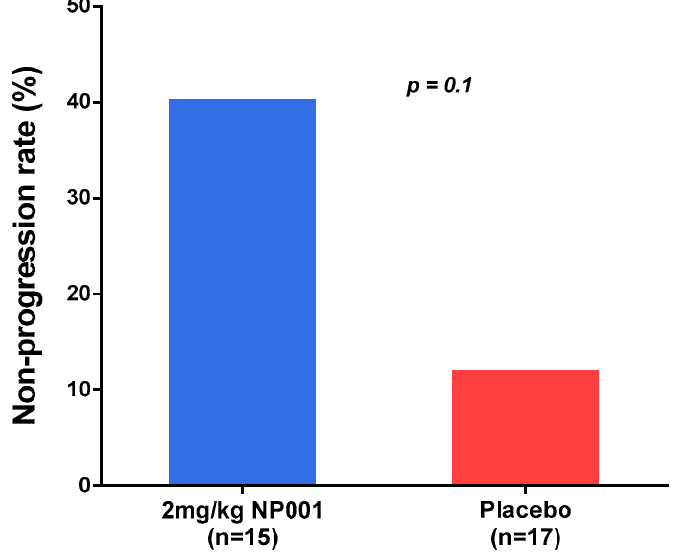
Figure 3. A subset of ALS patients did not progress over the 6-month study. Non-progressors were defined as those having no decrease in ALSFRS-R score at 6 months, by treatment group, restricted to those with plasma CRP > 1.13 mg/L and age between 40 and 65 years at baseline in phase 2A trial. The proportion of non-progressors (non-progression rate) in 2 mg/kg NP001 treatment (6 out of 15) was more than 3-fold higher than that of the placebo group (2 out of 17) (Fisher’s exact test, p = 0.1). Plasma specimens were evaluated for biomarker levels at baseline and at 6 months. All biomarker determinations were performed using the same assay system and on the same day by AssayGate. The number of patients who received 2 mg/kg NP001 or the placebo that had a baseline CRP > 1.13 mg/L, and had plasma specimens available from baseline and at 6 months for analysis, was 14 and 15, respectively. Baseline values for the NP001- treated and placebo patients were not statistically different from each other (Figures 4 and 5, left column). Results for the % biomarker change from baseline were broken into three categories based on whether the biomarker values in NP001-treated vs. placebo patients: (1) decreased, (2) increased, or (3) had no change. Factors that were significantly decreased in NP001 recipients as compared to placebo over 6 months were those associated with microbial translocation (LPS, LBP and HGF), monocyte trafficking (sCD163) and inflam- masome activation (IL-18) (Figure 4, right column). Biomarker values that significantly increased were those associated with either inflammation suppression (IL-10, neopterin) or wound healing (EGF) (Figure 5, right column). Plasma levels for IL-6, IL-8 and TNF-a were within the normal ranges and relatively stable over the six-month study (data not